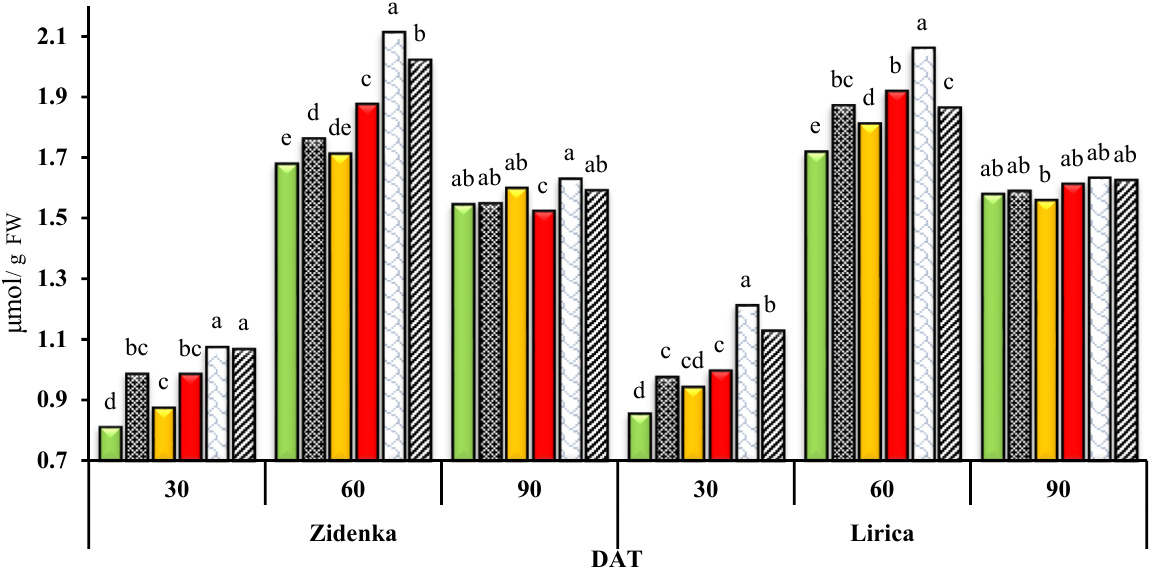
Figure 3. Effect of seedlings spray with different ozonated water concentrations and cold pretreatments on proline content of two pepper hybrids 30, 60, and 90 days after transplanting during the 2017/2018 ( upper figure) and 2018/2019 ( lower figure) seasons. The columns labeled with a lowercase letter are not significantly different according to Duncan’s multiple range test at 0.05 levels for the same sampling date in each season and each hybrid separately. * Cold stress treatment was performed at 4 °C for 36 h. The average value of three biological and three technical replicates is reported.